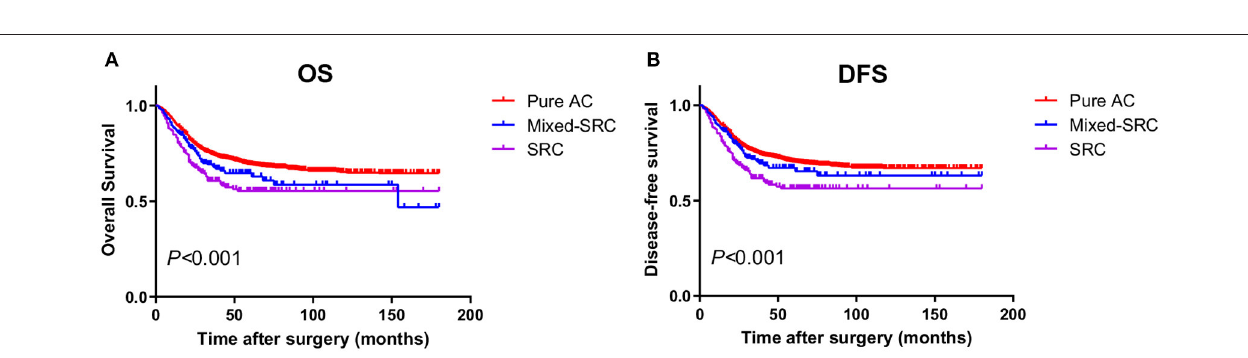
FIGURE 3 | The Kaplan–Meier survival curves of OS (A) and DFS (B) in gastric cancer patients in stage II/III.